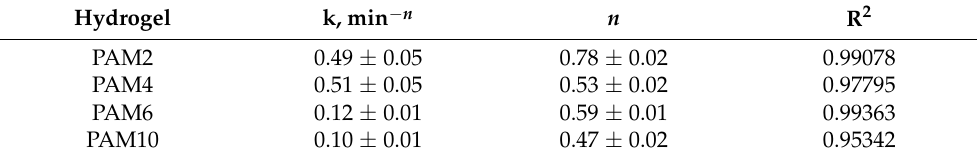
Figure 3. Swelling behavior of the prepared hydrogels (swelling data were fitted to the Korsmeyer– Peppas model). Table 2. Swelling parameters (Korsmeyer–Peppas model) of the prepared hydrogels.